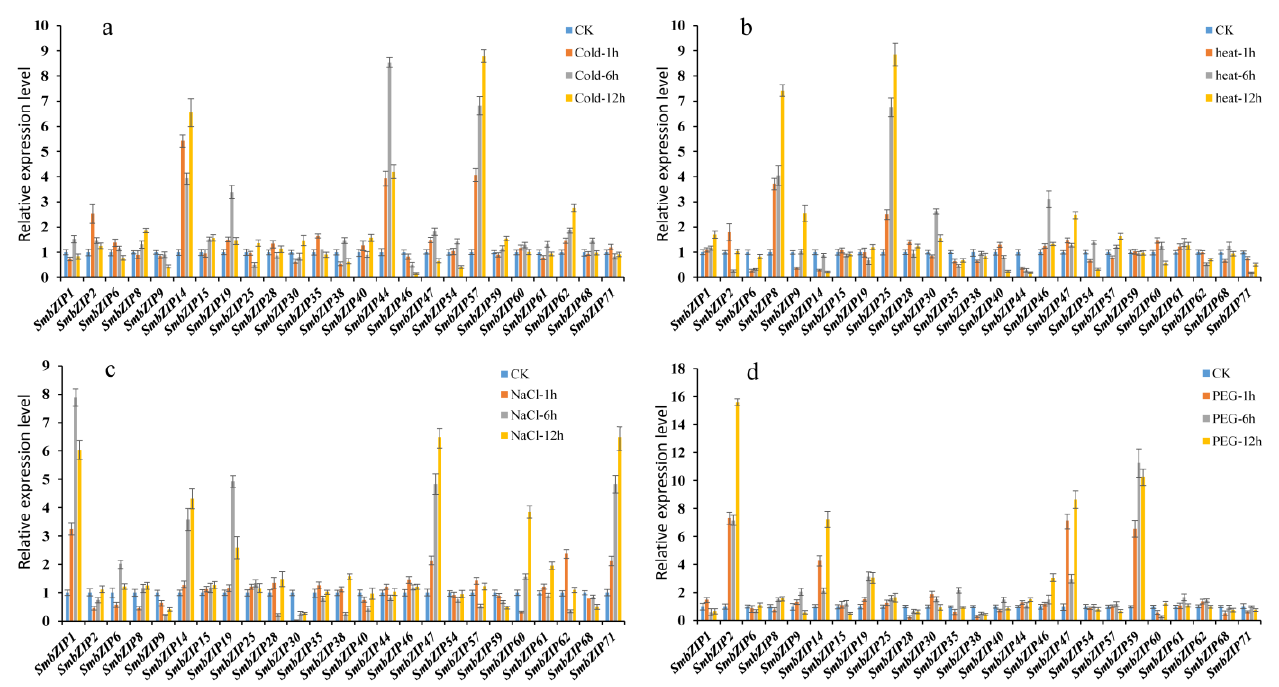
Figure 7. Expression analysis of 25 selected SmbZIP genes under four abiotic stresses. ( a ) The relative expression ratio of 25 selected SmbZIP genes under cold stress. ( b ) The relative expression ratio of 25 selected SmbZIP genes under heat stress. ( c ) The relative expression ratio of 25 selected SmbZIP genes under NaCl stress. ( d ) The relative expression ratio of 25 selected SmbZIP genes under PEG stress. Each treatment contains three time points: 1 h, 6 h, and 12 h.